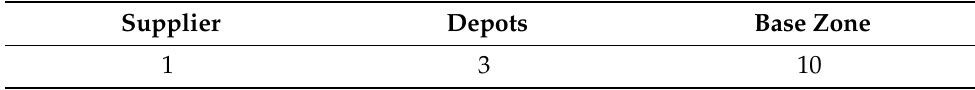
Table 1. The size of the problem.